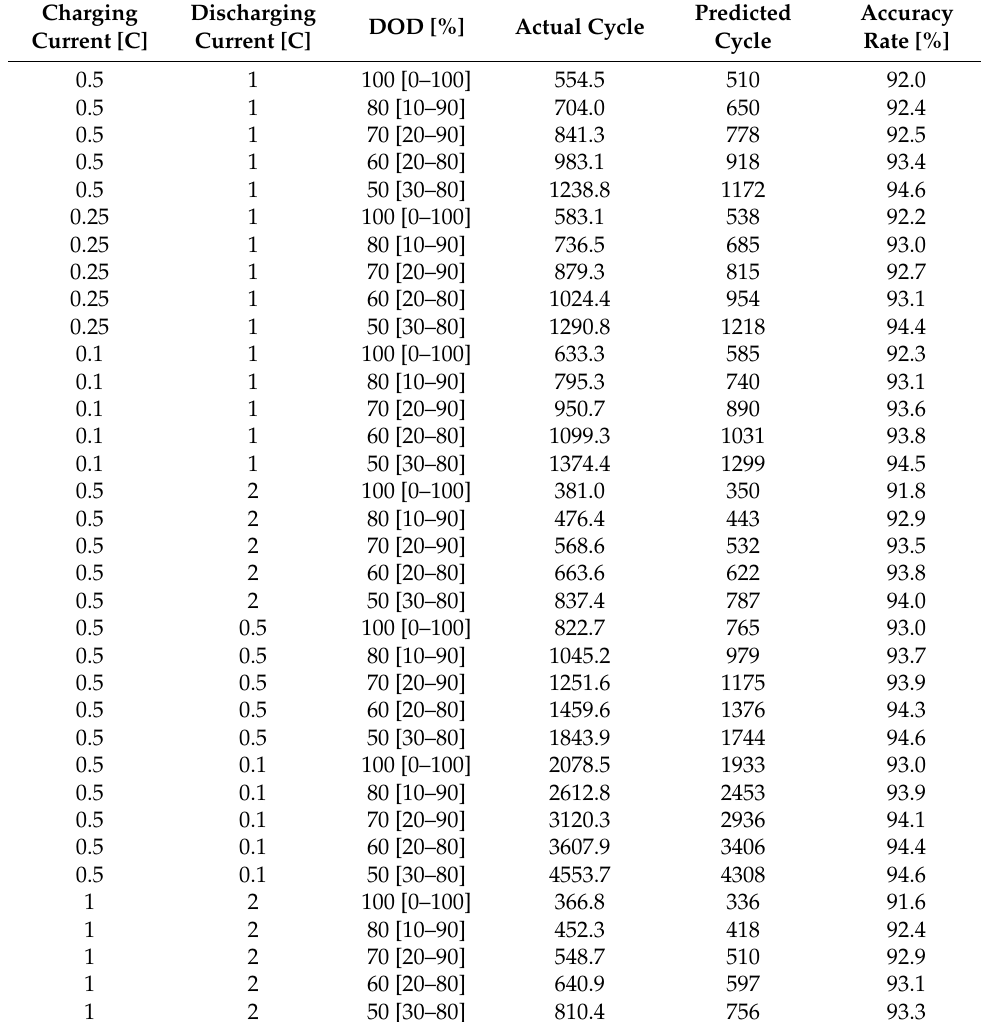
Table 3. The comparison of the predicted cycle and the actual